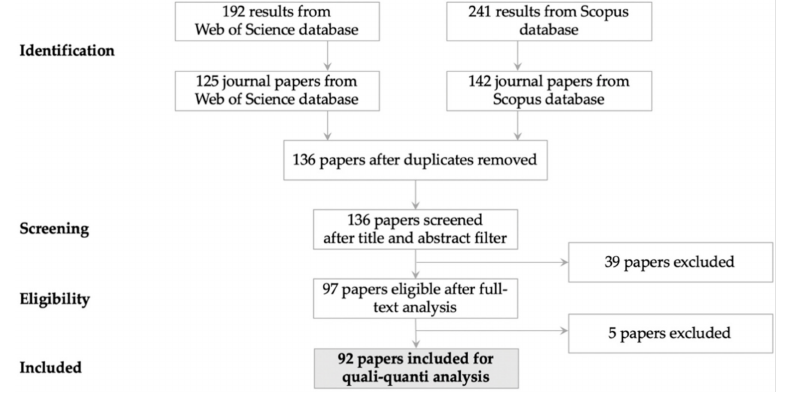
Figure 1. Delimitation of paper sample. Adapted from Moher et al.